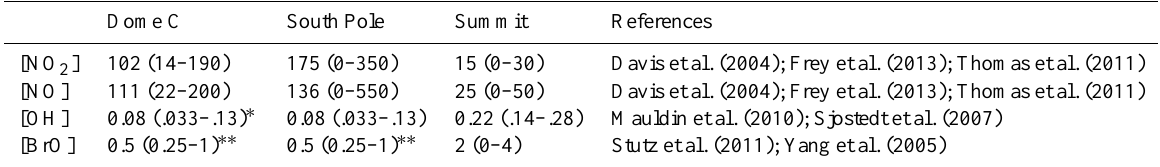
Table 4. Chemical concentrations (pptv) used in the NO x chemical lifetime ( τ chemical ) equations. The summertime base-case values of boundary layer [NO 2 ], [NO], [OH], and [BrO] are provided along with the range of values used in the sensitivity studies in parentheses. Dome C South Pole Summit